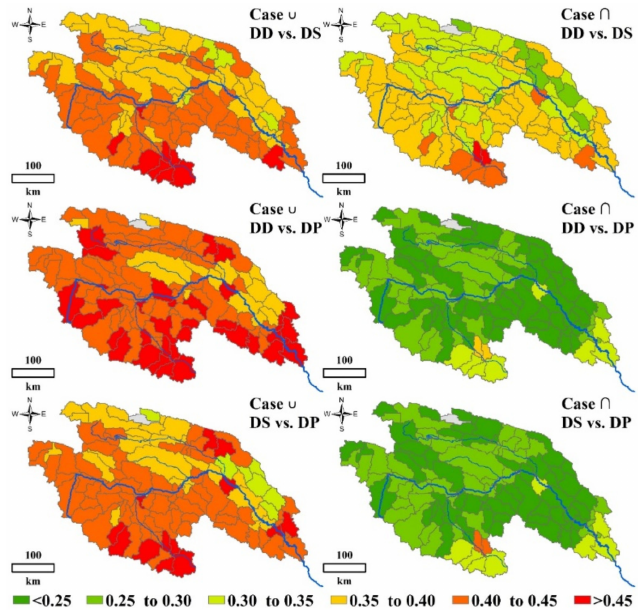
Figure 16. Spatial distribution of bivariate probabilities of DD vs. DS , DD vs. DP and DS vs. DP in Case ∪ and Case ∩ in the